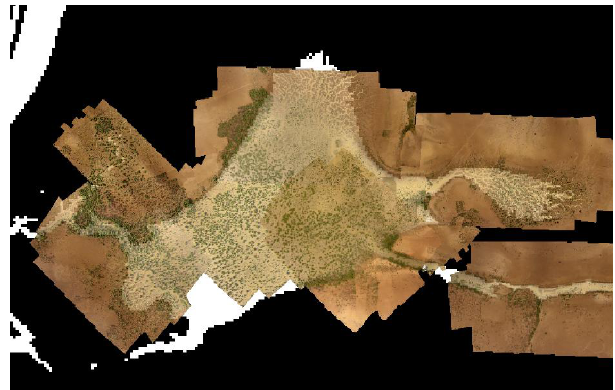
Figure 1. UAV imagery of the flooded areas superposed to the clas- sified Sentinel-2 image showing flooded area in white (5 October